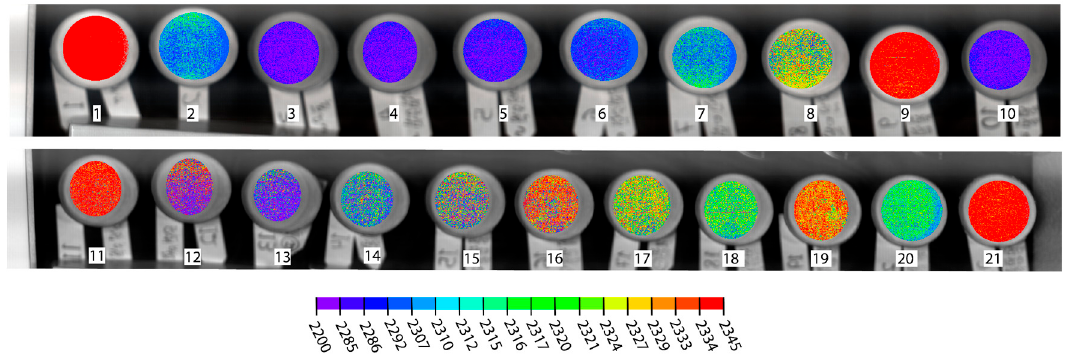
Figure 4. Absorption minimum maps of mixtures prepared in the laboratory (abundances shown in